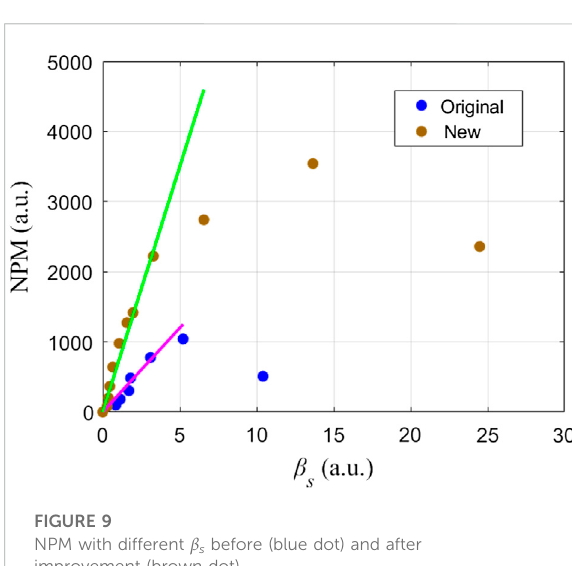
FIGURE 9 NPM with different β s before (blue dot) and after improvement (brown